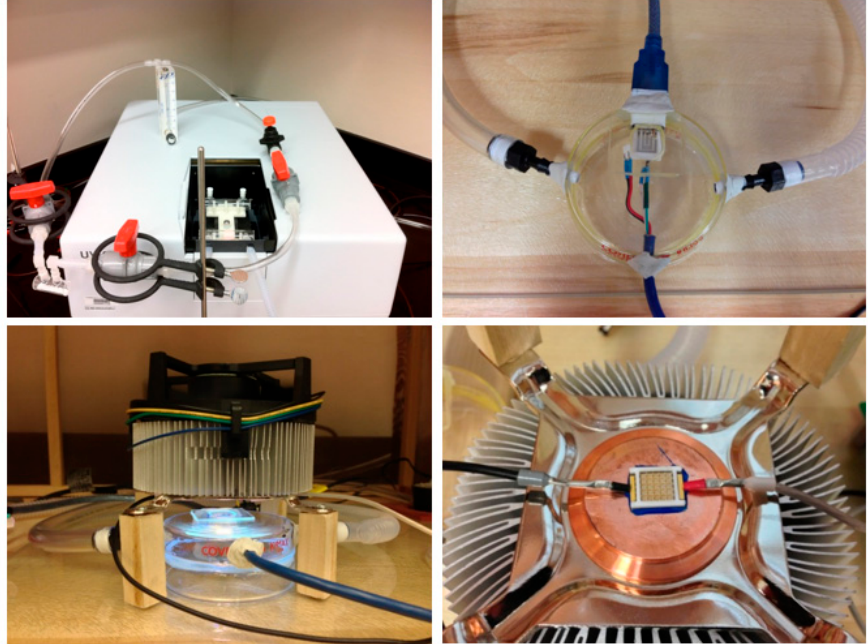
Figure 3. Pictures of: flowmeter, analyte chamber, and connections to the spectrophotometer ( top left ), sensor inside its glass chamber ( top right ), UV illumination ( bottom left ), and LED array with its cooling system ( bottom right ).